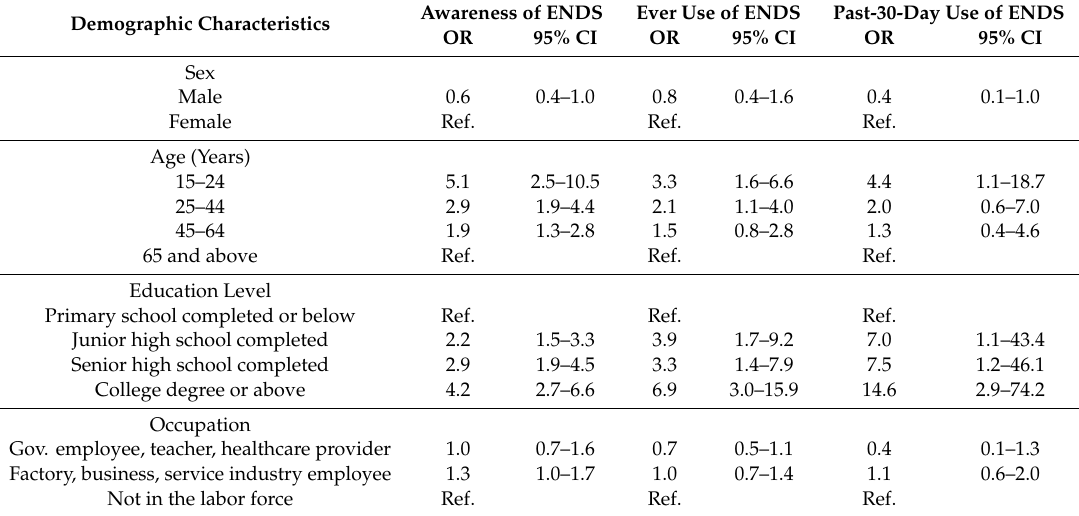
Table 4. Adjusted 1 ORs of awareness, ever use, and past-30-day use of ENDS among adult smokers in five Chinese cities in